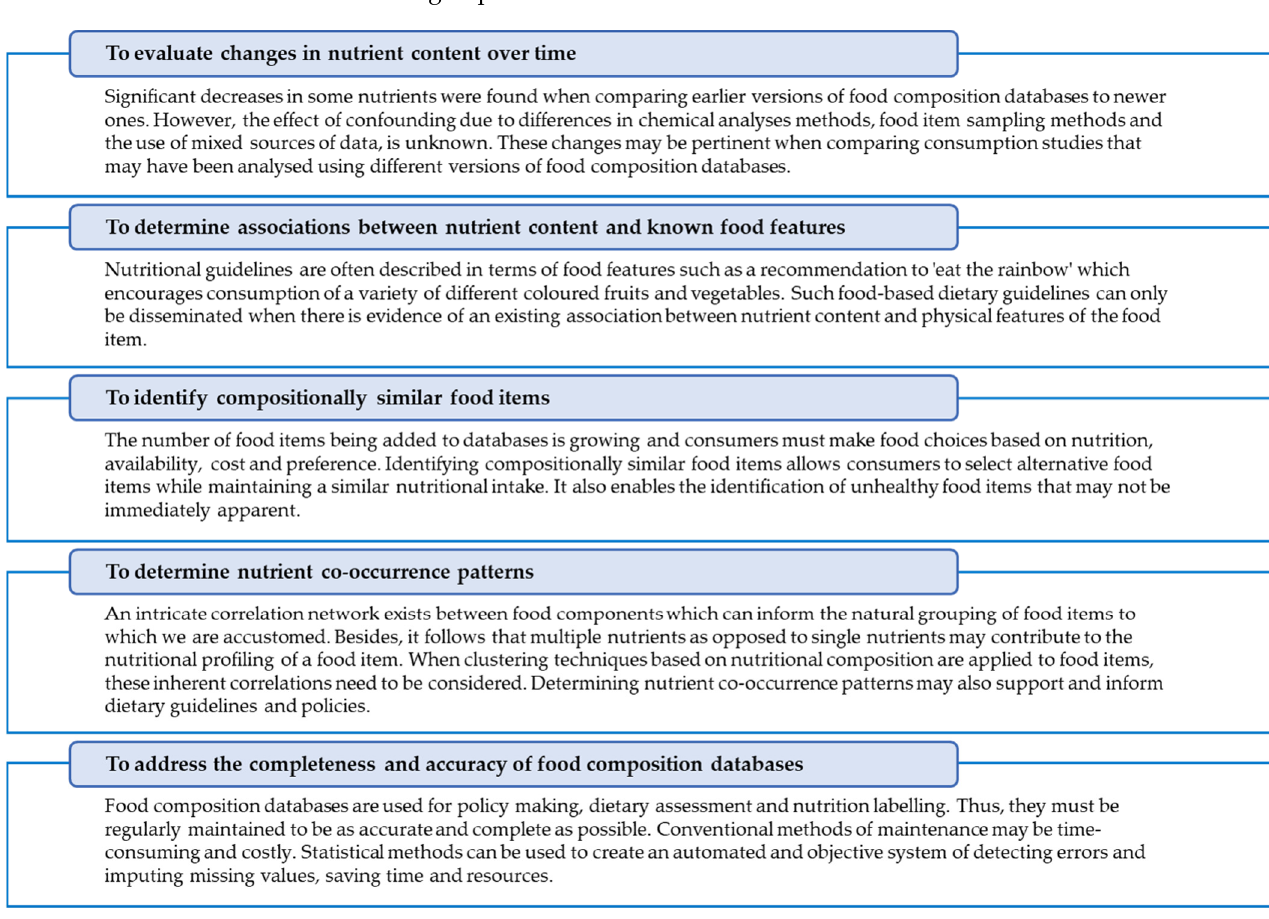
Figure 2. Themes from the literature on the application of statistical methods to food composition data.